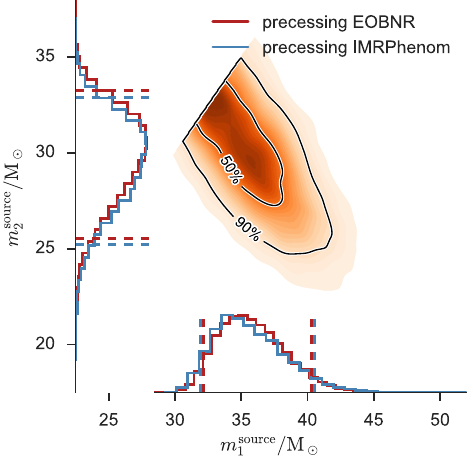
FIG. 2. Posterior probability densities for the source-frame component masses m source 1 and m source 2 , where m source 2 ≤ m source 1 . We show one-dimensional histograms for precessing EOBNR (red) and precessing IMRPhenom (blue); the dashed vertical lines mark the 90% credible intervals. The two-dimensional density plot shows 50% and 90% credible regions plotted over a color- coded posterior density function. Posterior histograms: Spin directions. — Figure 4 repro- duces the disk plot of Ref. [2] for precessing EOBNR. In this plot, the three-dimensional histograms of the dimen- sionless spin vectors S 1 ; 2 =m 2 1 ; 2 are projected onto a plane perpendicular to the orbital plane; the bins are designed so that each contains the same prior probability mass (i.e., histogramming the prior would result in a uniform shad- ing). It is apparent that the data disfavor large spins aligned or antialigned with the orbital angular momentum, con- sistently with precessing IMRPhenom results. Because precessing EOBNR favors smaller values of the dimen- sionless spin magnitudes, the plot is darker towards its